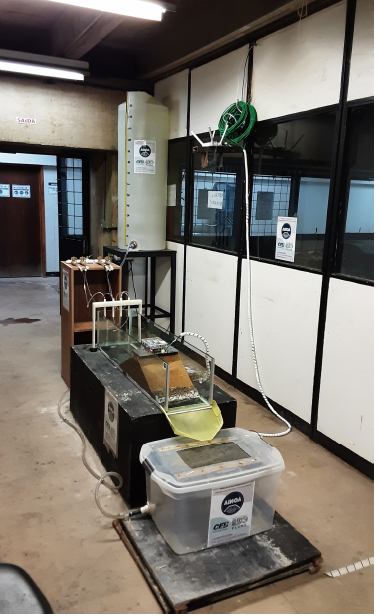
Figure 3. Lateral view of experimental